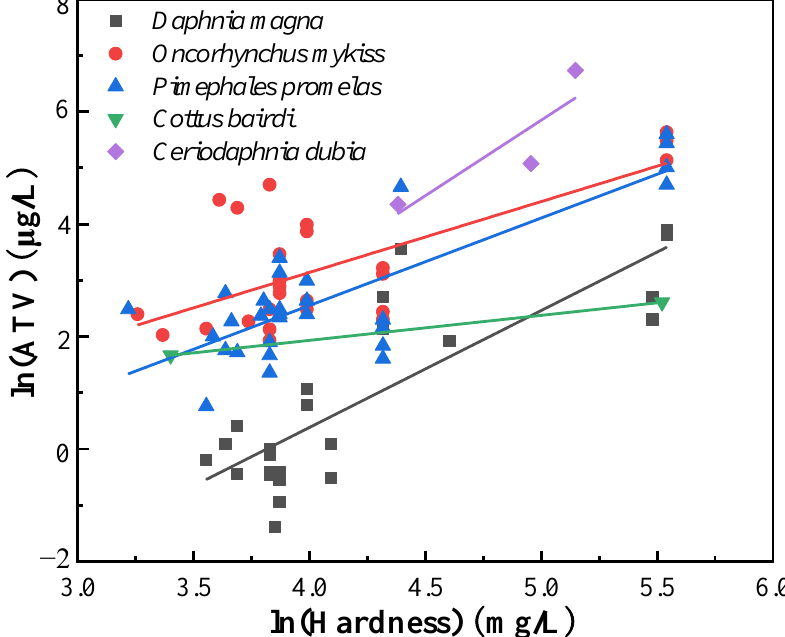
Figure 2. The linear relationship between the natural logarithms of the hardness and the natural logarithms of the ATVs of silver ions for Daphnia magna , Oncorhynchus mykiss , Pimephales promelas , Cottus bairdi , and Ceriodaphnia dubia .